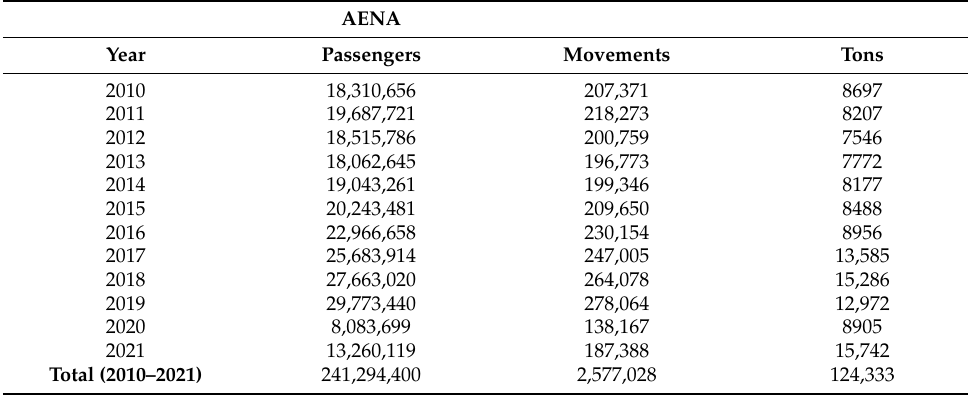
Table 2. AENA passenger, aircraft, and cargo movements (2010–2021).